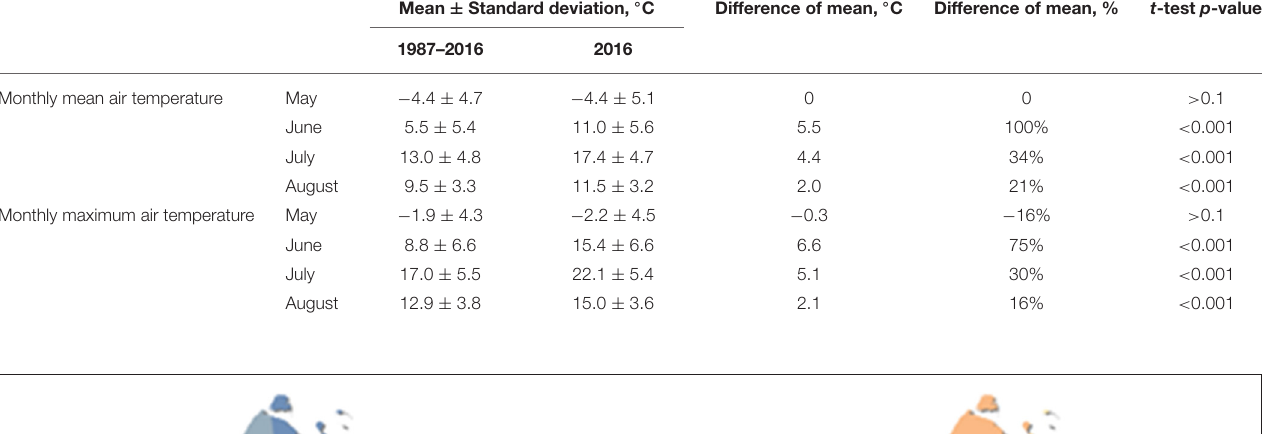
TABLE 1 | The results of air temperature comparison in May, June, July, and August 2016 with corresponding indicators for 1987–2016 based on weather station Antipayuta data.